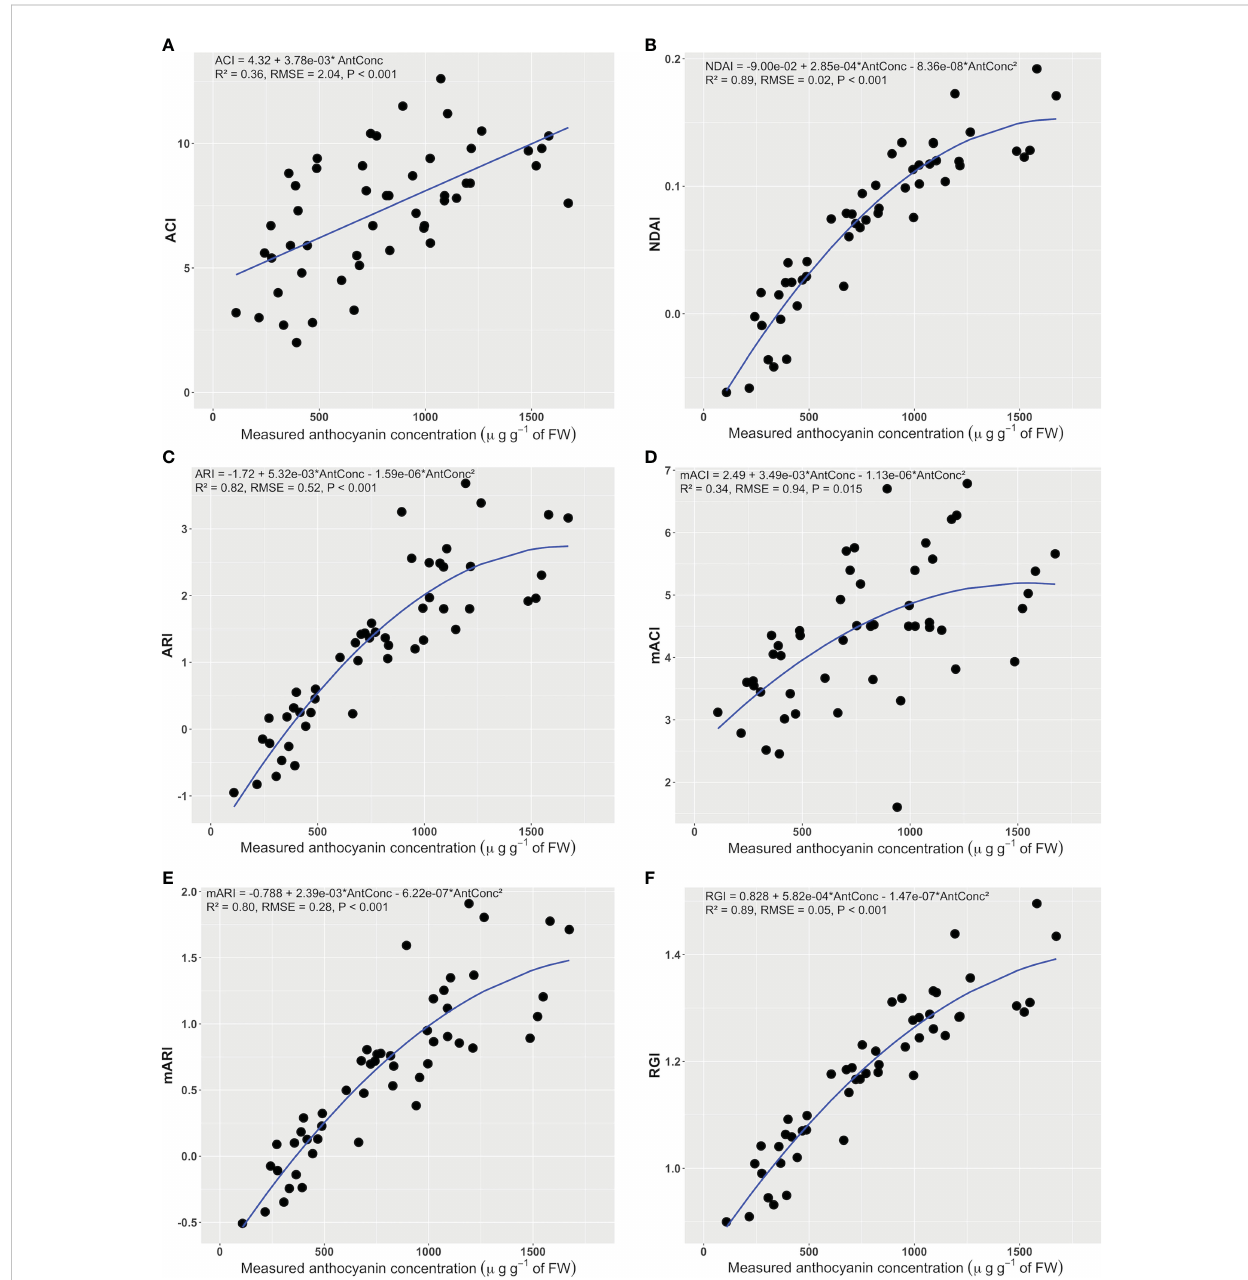
FIGURE 4 The relationship between the anthocyanin concentration of leaf discs and the corresponding anthocyanin content index of a hand-held anthocyanin content meter (ACI) (A) , anthocyanin content index (B) , anthocyanin re fl ectance index (ARI) (C) , modi fi ed anthocyanin re fl ectance index (mARI) (D) , modi fi ed anthocyanin content index (mACI) (E) , and red to green ratio index (RGI) (F) (n = 50). The regression summaries include the regression equation, coef fi cient of determination, root mean square error, and p-value. The blue curves show the regression